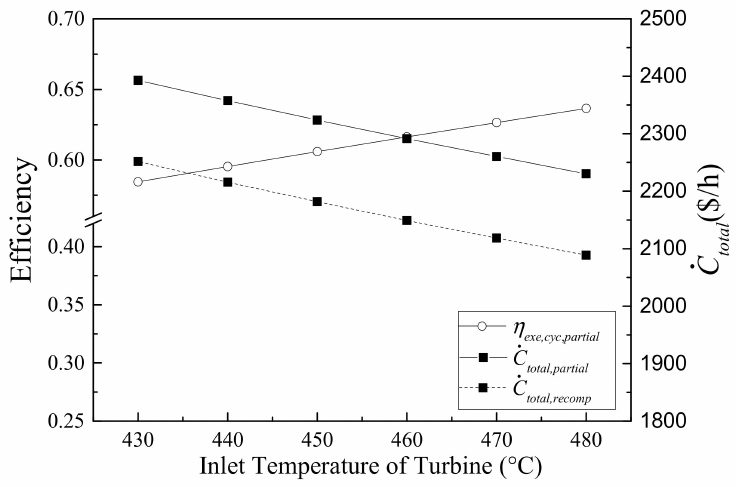
. C total with the partial-cooling cycle compared with the